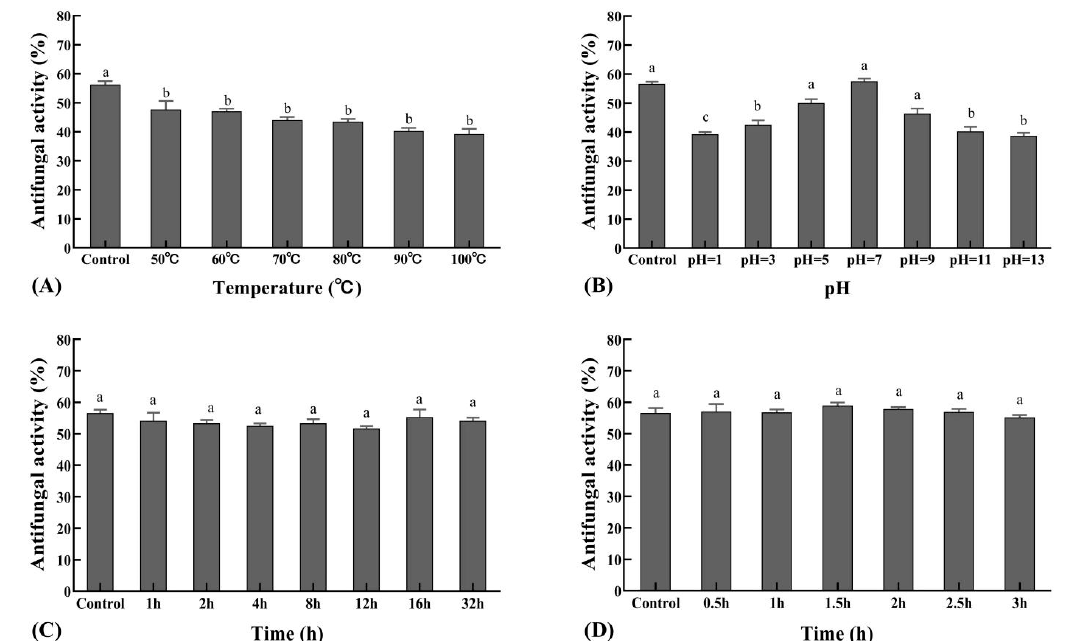
Figure 6. Stability of the sterile filtrate to varying temperature, pH, UV, and illuminated light. ( A ). The effect of XZ18-3 sterile filtrate on R. cerealis treated under different temperatures. ( B ). The effect of XZ18-3 sterile filtrate on R. cerealis treated under different pHs. ( C ). The effect of XZ18-3 sterile filtrate on R. cerealis treated with 254 nm UV light for different lengths of time in hours . ( D ). Effect of XZ18-3 sterile filtrate on R. cerealis treated with 4500 ± 500 lx illuminated light for different lengths of time in hours. Different letters above the bars indicate significant differences at p < 0.05 (according to Duncan’s multiple range test).